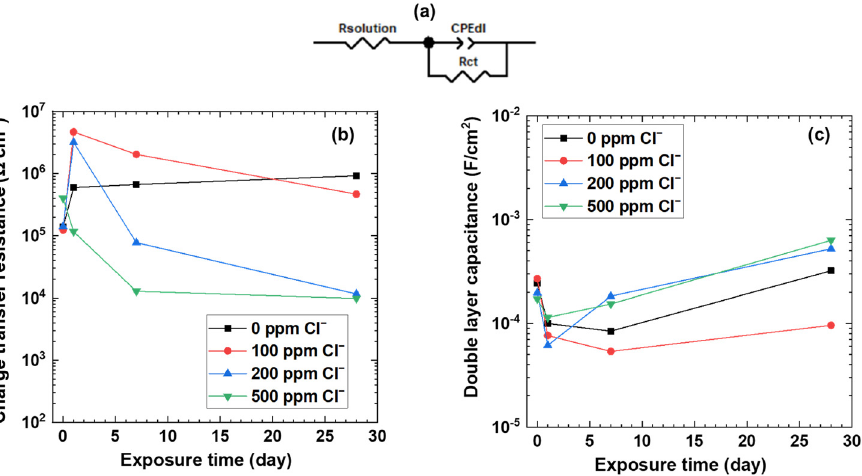
Figure 6. Equivalent circuit employed to fit the EIS data is shown in ( a ) and the trends of electrochemical parameters; charge transfer resistance and double layer capacitance are presented in ( b ) and ( c ), respectively.